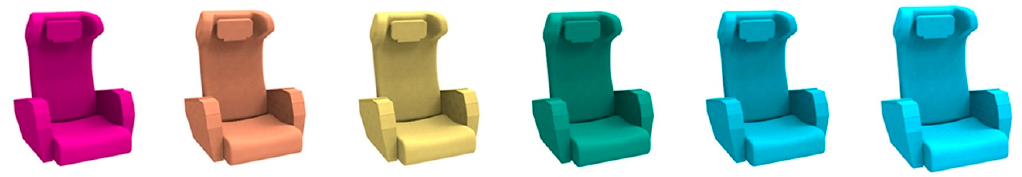
Figure 9. The 6 color experimental samples of the train seat form sample No. 2.